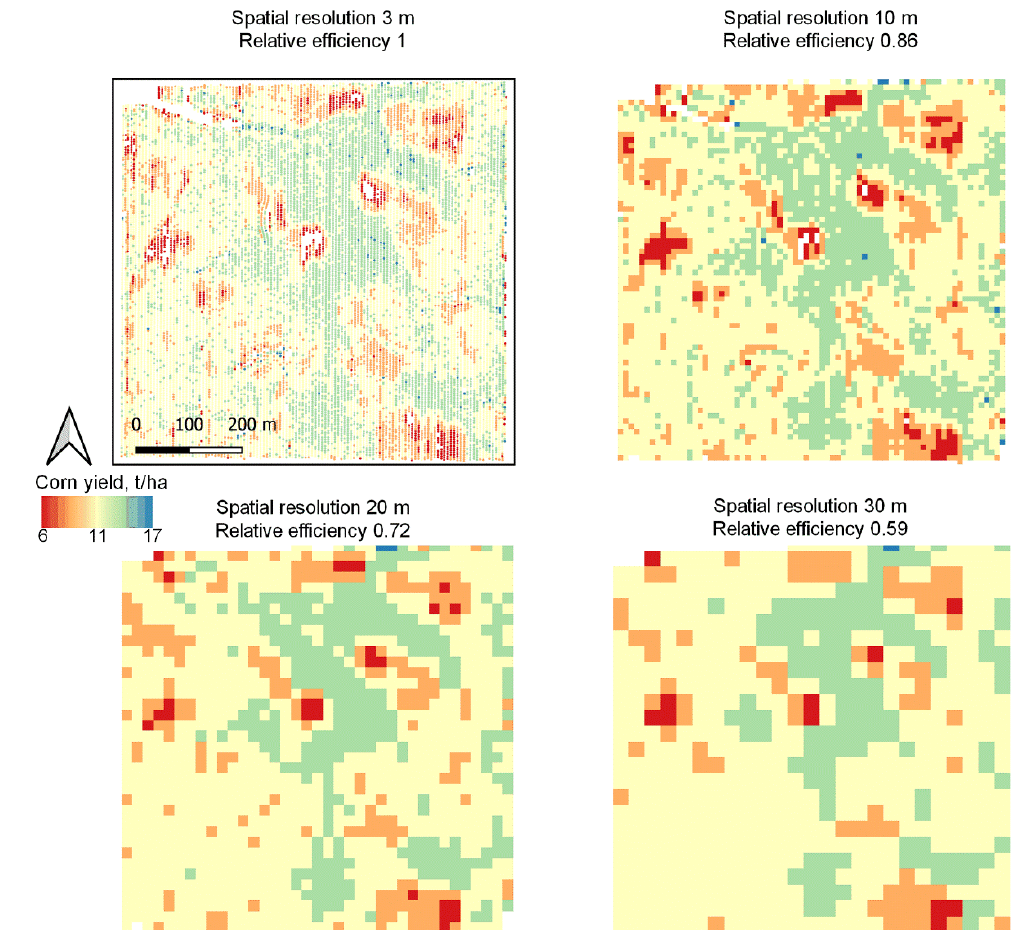
Figure 5. Dependence of the relative efficiency, the metric showing how well one can capture yield variability, on spatial resolution. These results were obtained by simulating yields from the harvester machinery at various spatial resolutions.